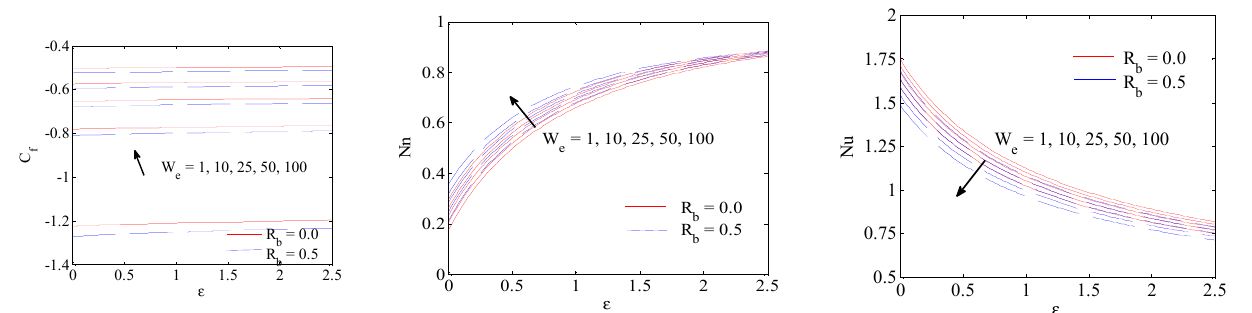
Figure 2. Fluctuations of C f , Nu and Nn due to W e